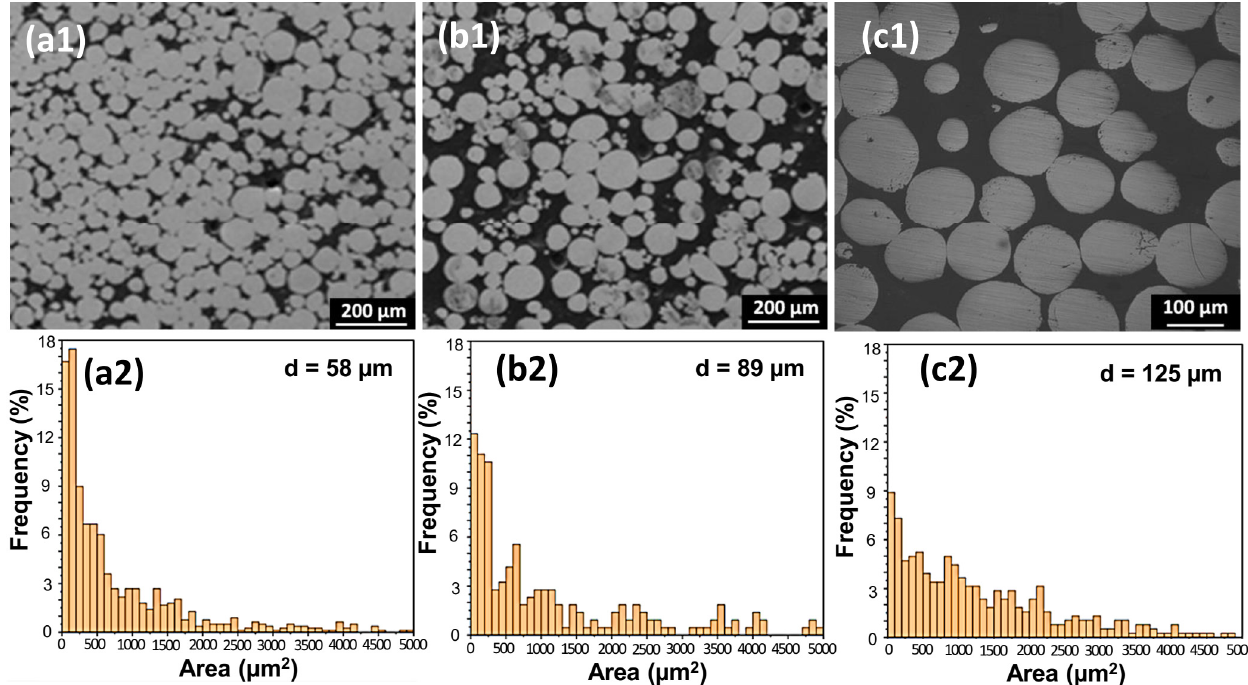
Figure 6. Cross-sectional SEM image and pore area distribution of the samples prepared by using different spherical Cu powders after sintering ( a1 , a2 ) 58 µ m, ( b1 , b2 ) 89 µ m, and ( c1 , c2 ) 125 µ m.